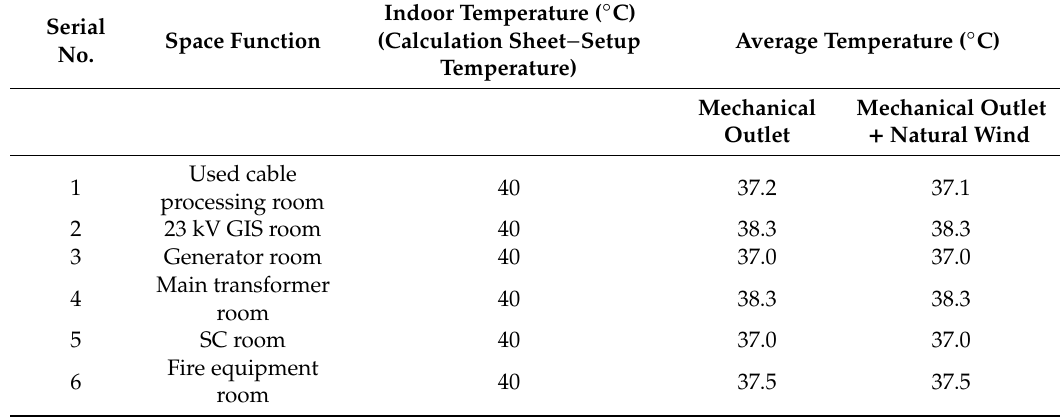
Table 10. Indoor space average temperature analysis results under two